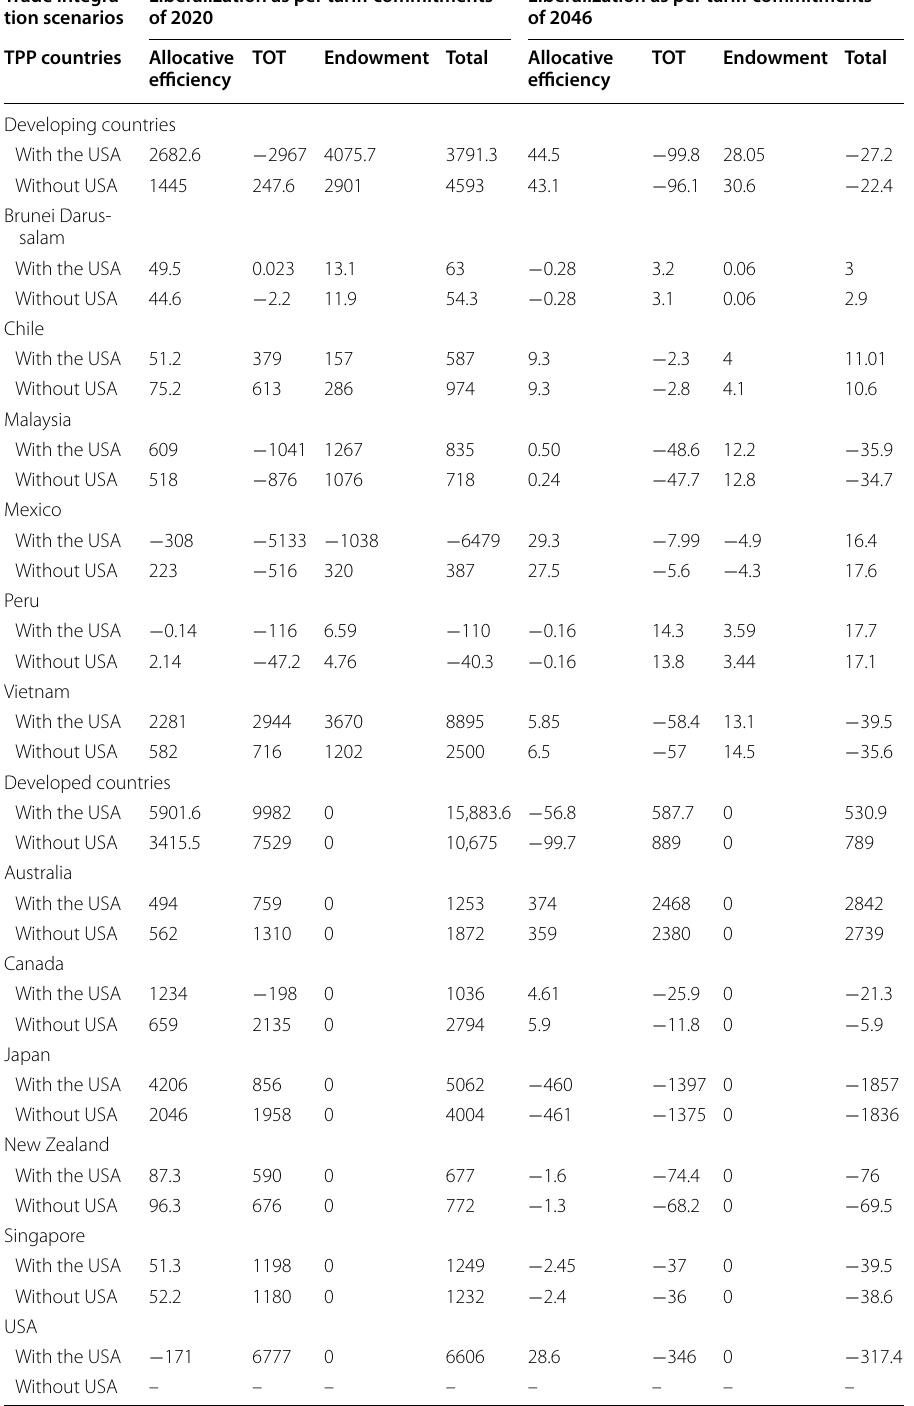
Table 3 Welfare results for TPP members under different trade integration scenarios (US $million). Source : based on simulation